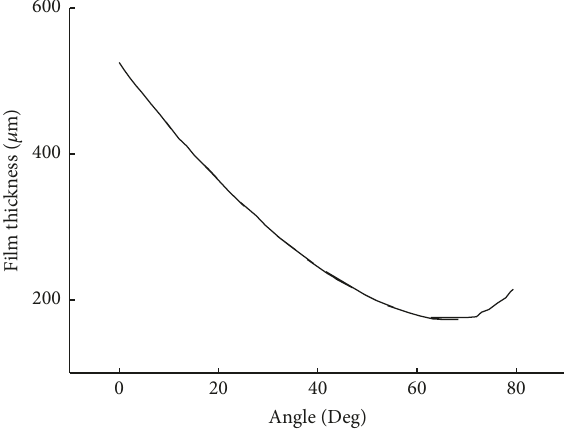
Figure 3: Measured film thickness at 3000 r/min and under 180kN loading [25].